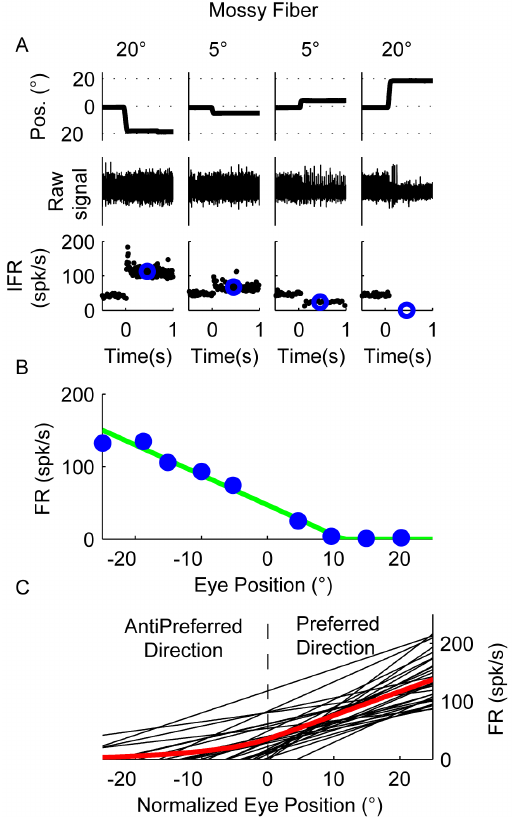
Figure 2. Responses of mossy fibers. ( A ) Raw data showing the response of an example mossy fiber to 5 deg and 20 deg leftward and rightward off-center fixation trials. The upper row shows horizontal eye position (negative values for leftward eye position and positive for rightward eye position), the middle raw spike data, and the bottom row instantaneous firing rate (IFR, black dots). Blue circles in the lower row represent the average firing rate following each saccade (200–700 ms). ( B ) Relationship between average firing rate and eye position using data from trials like those shown in A. ( C ) Best fitting line for each mossy fiber that could be well fit with F 1 , showing the relationship between eye position and firing rate. The eye position has been normalized to display the preferred direction of the neuron as positive. The average response profile across all mossy fibers is shown in red.